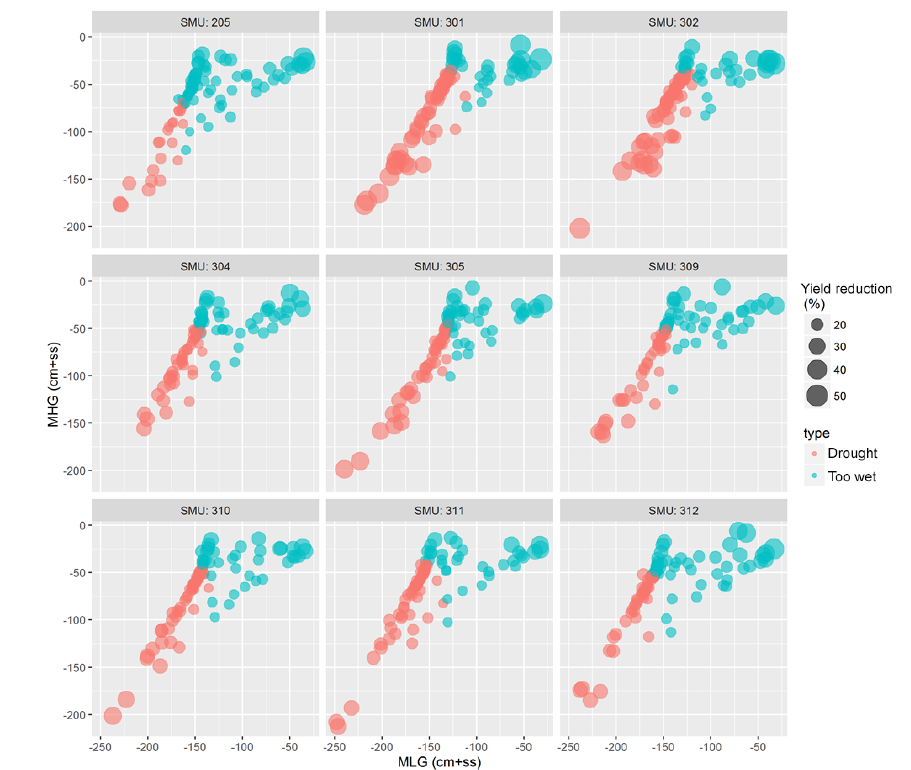
Figure 8. Meta-model WaterVision Agriculture: examples for nine different soil types of the BOFEK database (SMU = Soil Mapping Unit) for grassland and the current climate in De Bilt, with the mean highest groundwater level (MHG) on the y axis and the mean lowest groundwater level (MLG) on the x axis. Red dots represent crop yield reduction due to drought and blue dots represent crop yield reduction as a result of too wet conditions (oxygen stress).